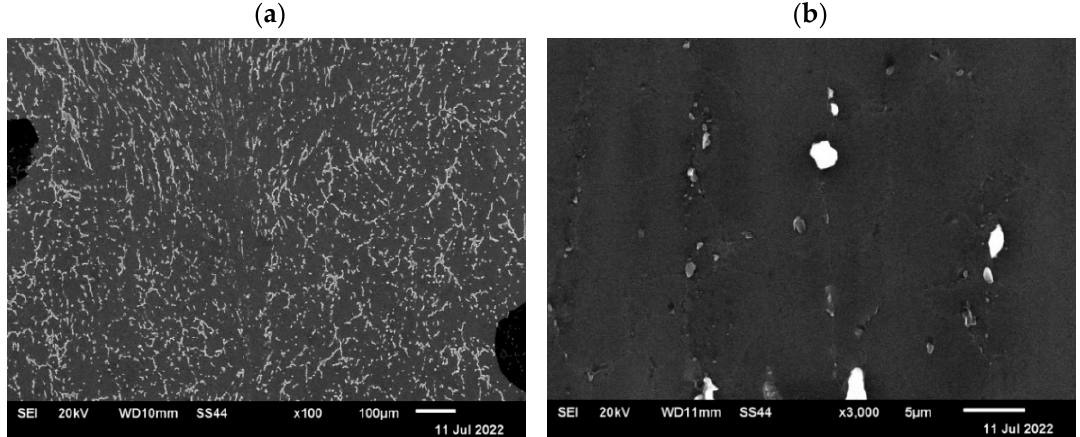
Figure 22. The microstructure of the sample with a circular cross-section in the area of the axis after plastic deformation disclosed in the SEM analysis: ( a )—magnification ×100; ( b )—magnification ×3500.